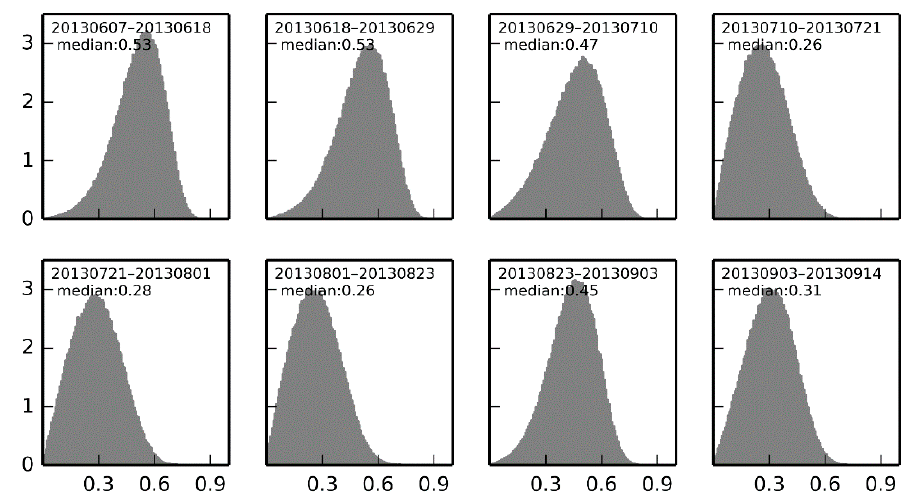
Figure A2. Normalized histograms of coherence values for the eight minimum time span interferograms (an area without water bodies was chosen for sampling—see black box in Figure A3).